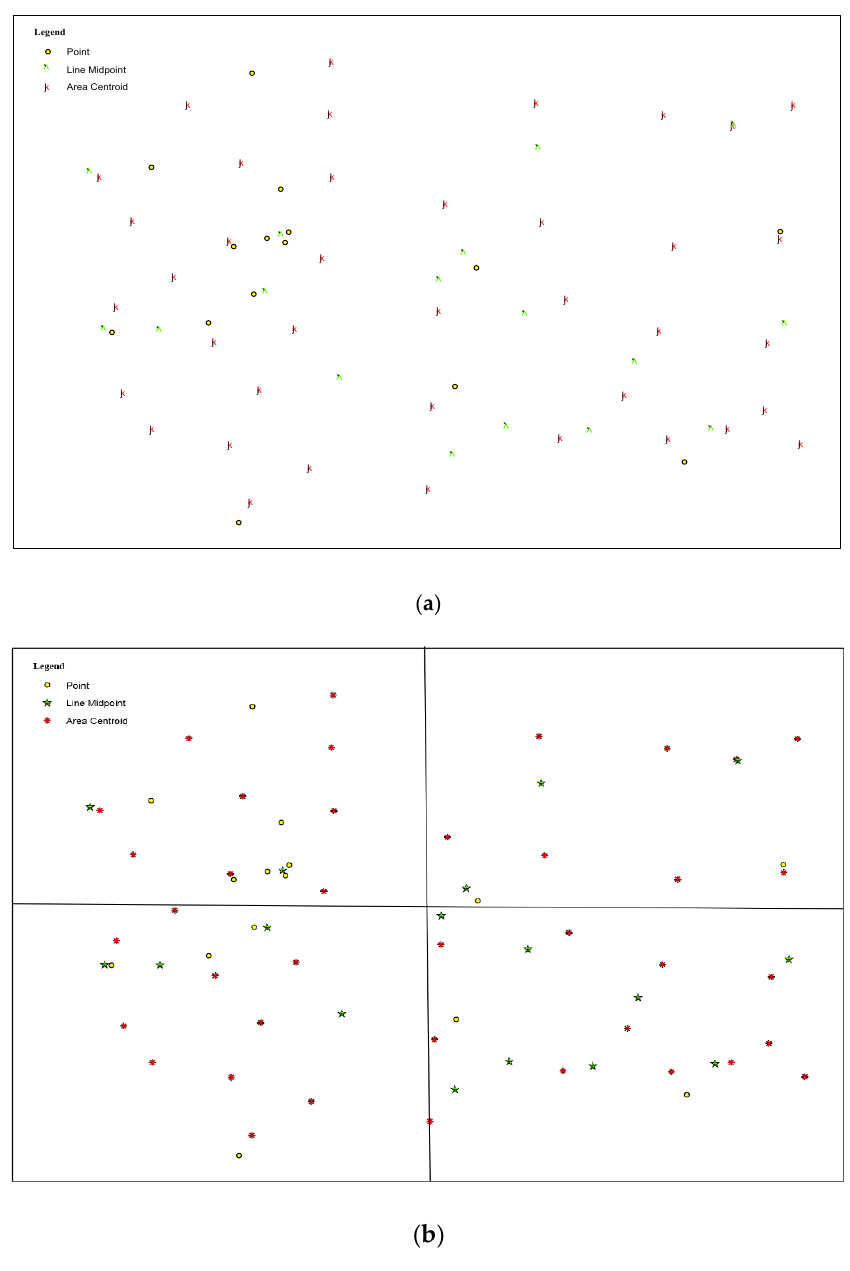
Figure 2. A representation of multiple geographical features, which are polygon, line, and point features. In addition, the centroids of area features and the midpoints of line features are shown.